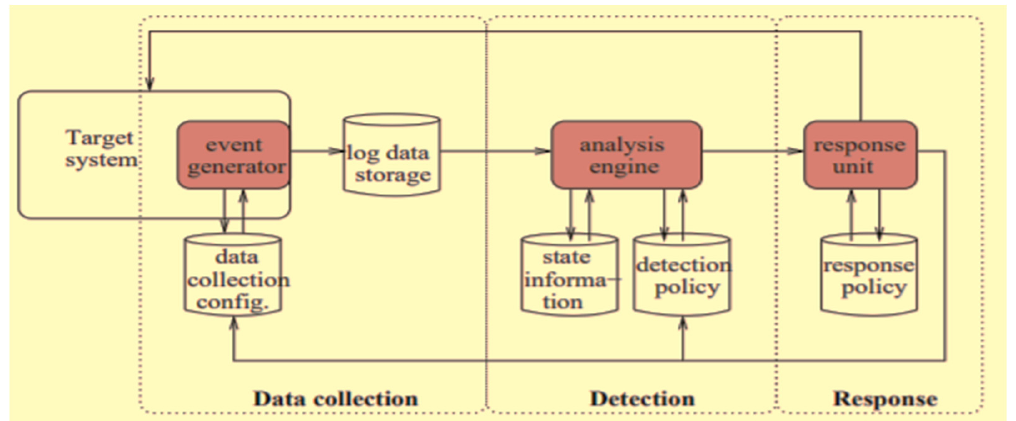
Figure 2. Components of a general IDS [28].